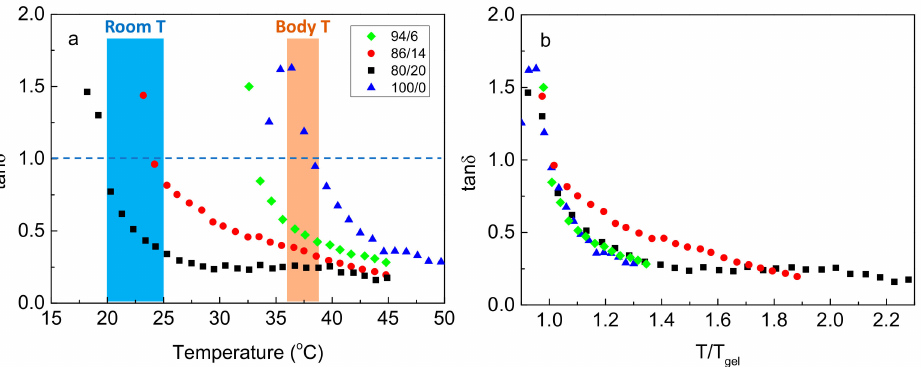
Figure 4. ( a ) Temperature dependence of the loss tangent (tan δ ) at 1 Hz for the systems indicated. The two-colored zones mark the room and body temperature. ( b ) Loss tangent (tan δ ) as a function of the normalized temperature T/T gel (symbols as in ( a